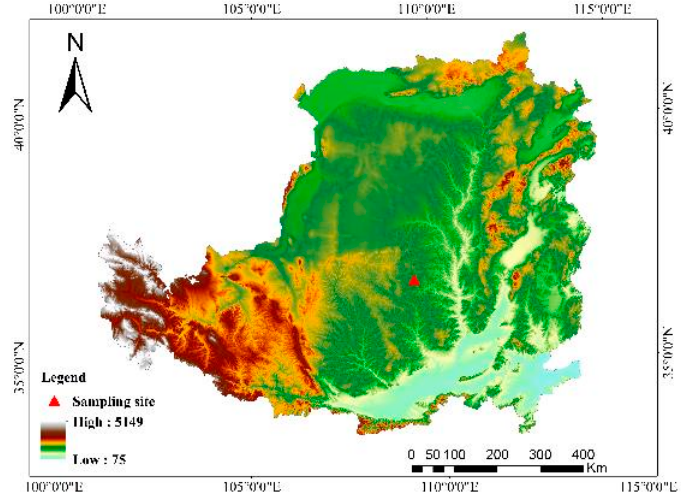
Figure 1. Geographical location of the study